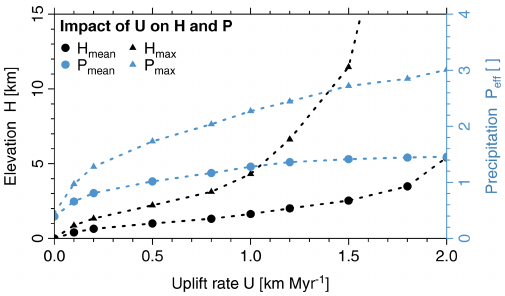
Figure 10. Uplift rate control on precipitation rate and mountain height. Mean and maximum values for precipitation and elevation are computed for the domain of the mountain range only.